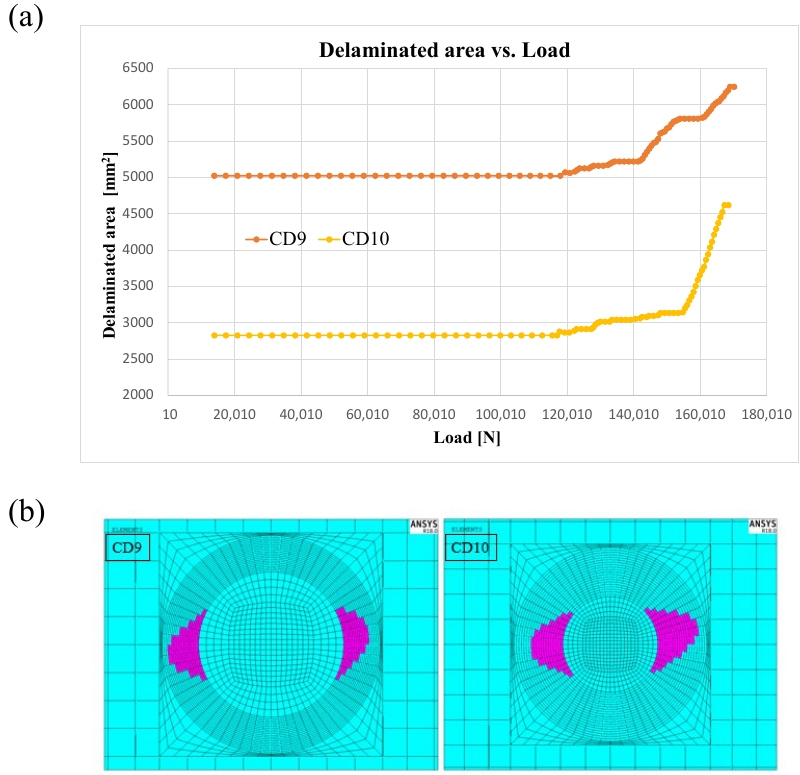
Figure 10. CD9–CD10 configurations: ( a ) delaminated area vs. load curves; ( b ) delamination evolution at final analyses load (pink represent the delaminated area).